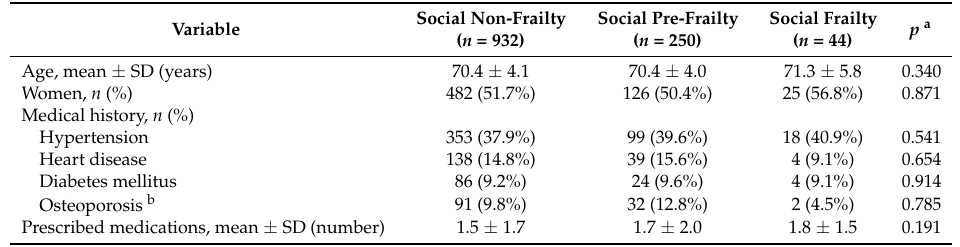
Table 1. Baseline characteristics of the participants, mean ± SD or